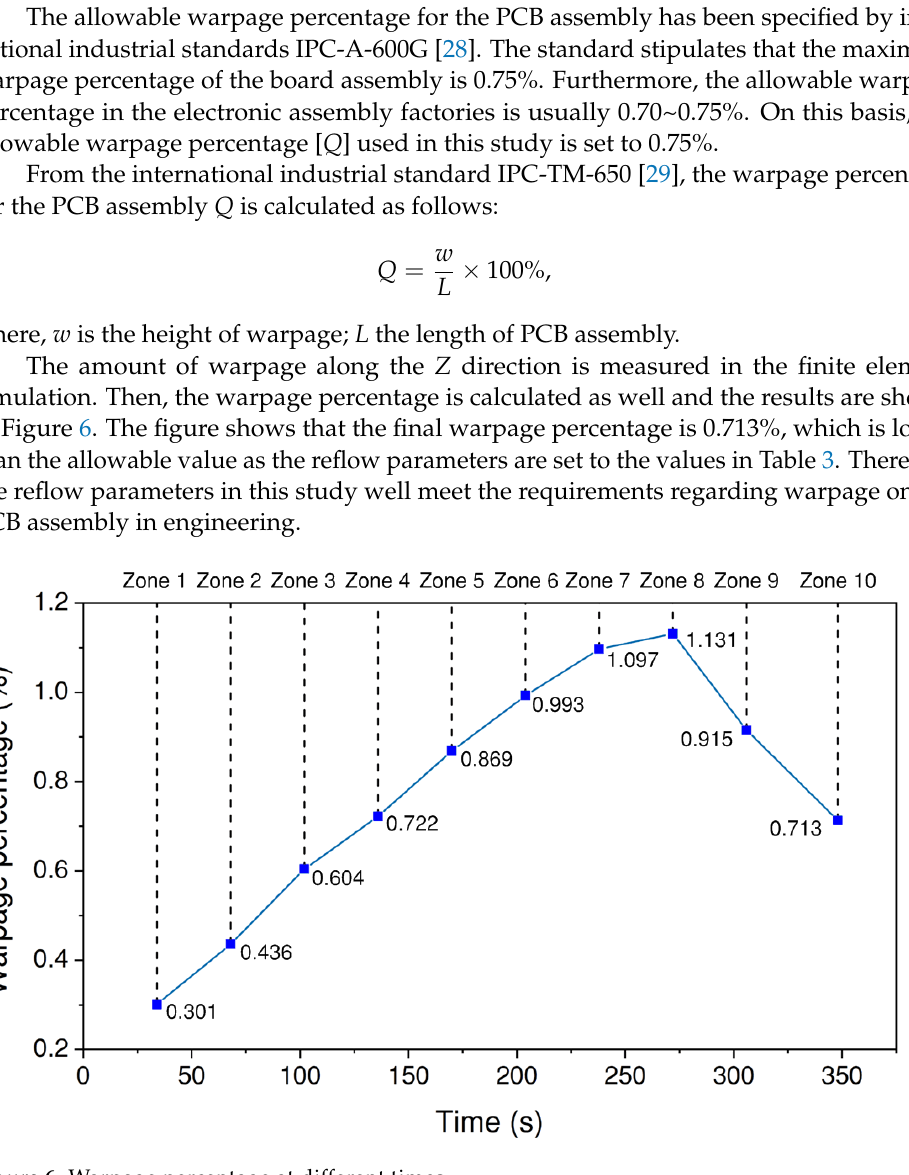
Figure 6. Warpage percentage at different times.